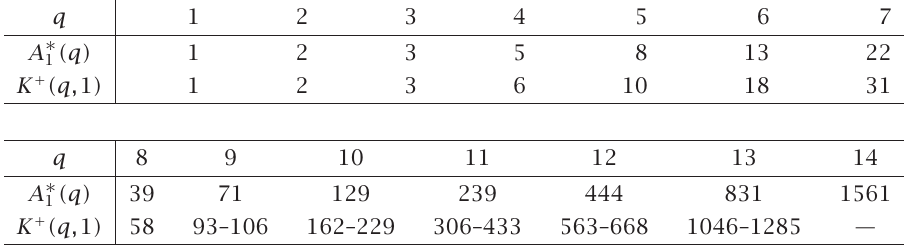
(q) , the minimum number of elements n for which Table 3.1 . Values of A ∗ 1 Paul can win the q -round pathological liar game with one half-lie, versus K + (q, 1 ) , the minimum number of asymmetric balls of radius 1 needed to cover Q q